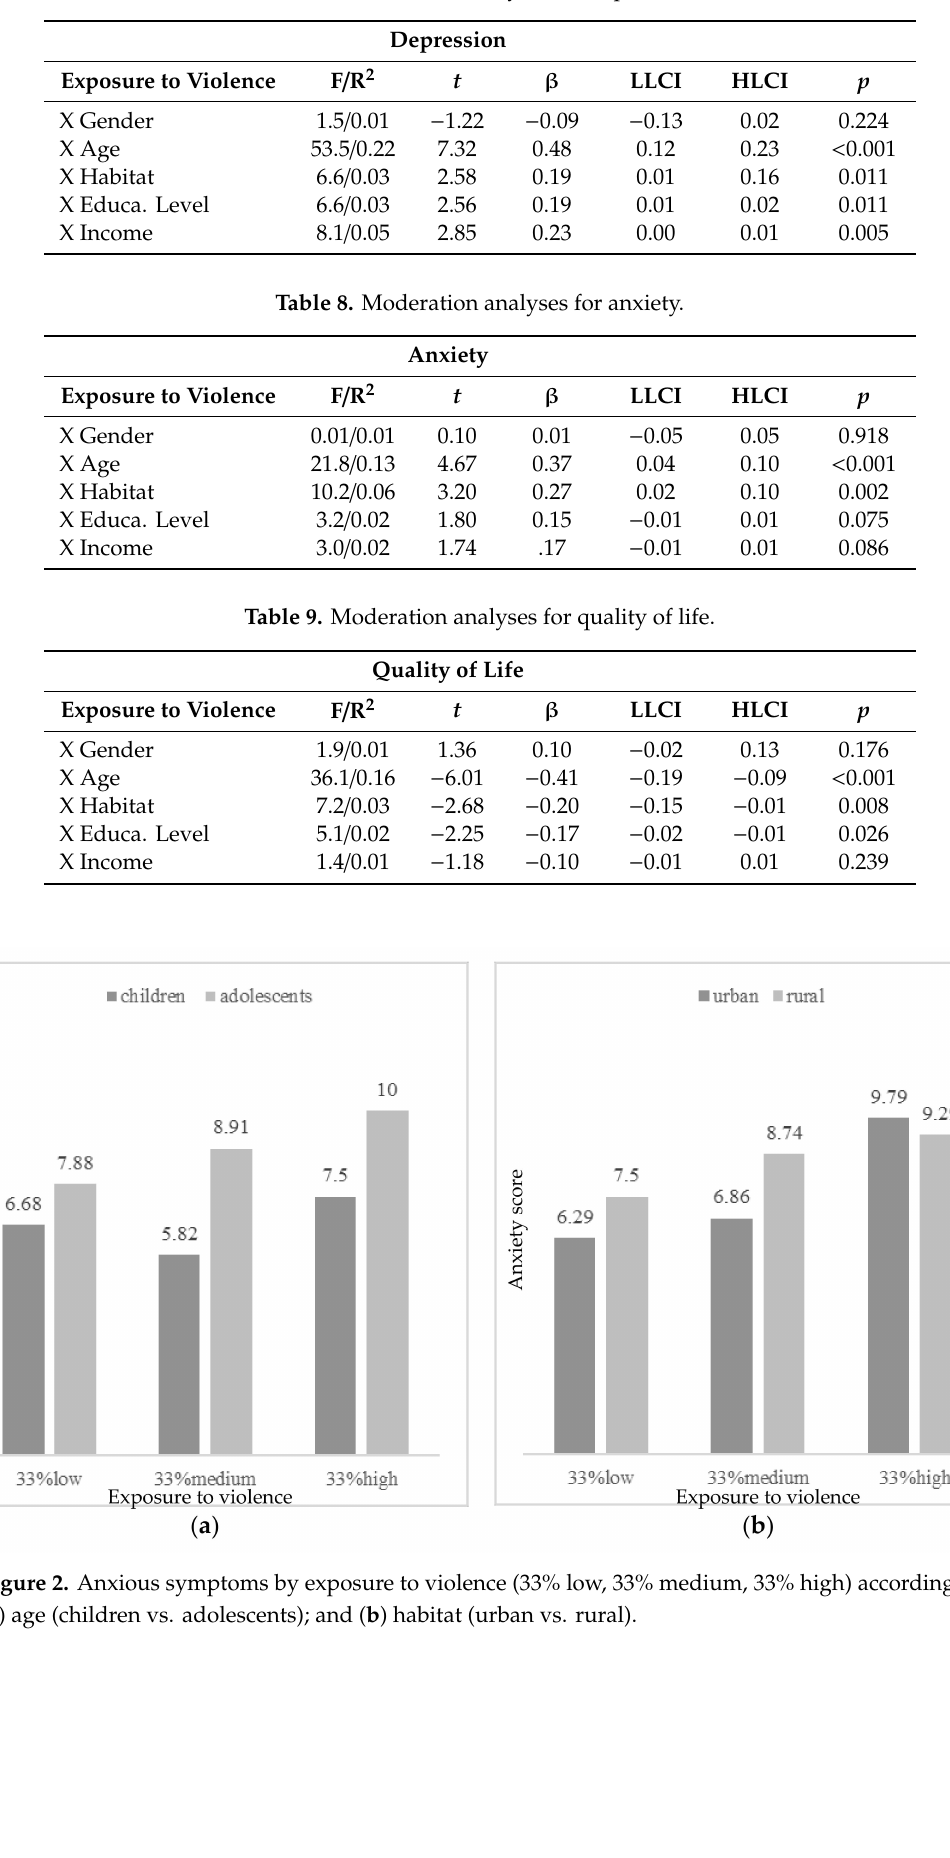
Table 7. Moderation analyses for depression.